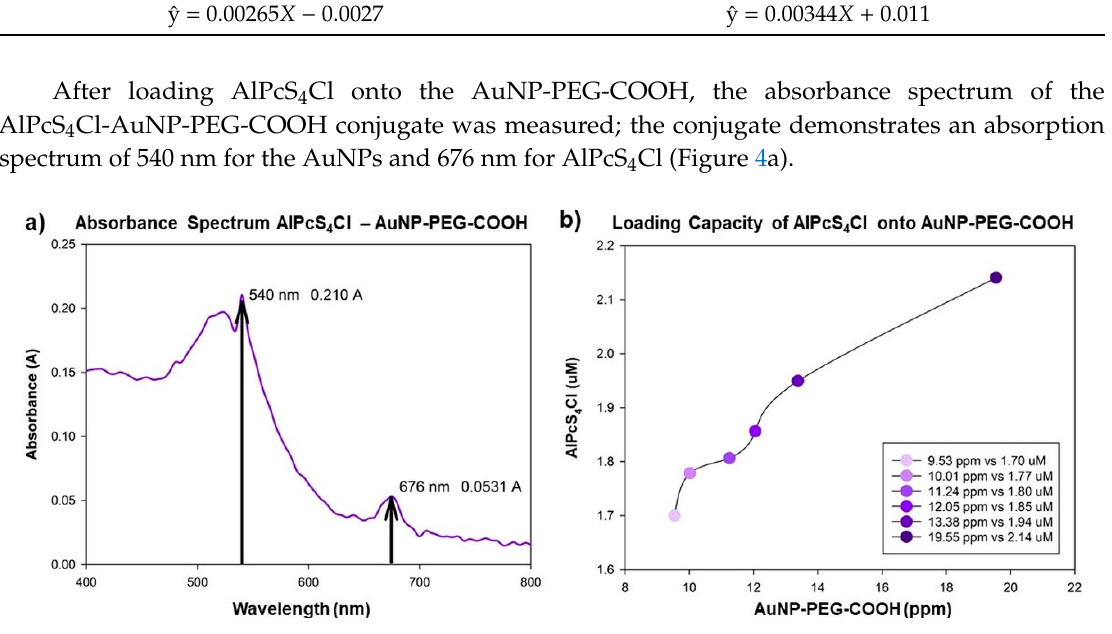
Figure 4. ( a ) Absorbance spectra of conjugated AuNP-AlPcS 4 Cl, with the particle’s respective absorbance peaks at 540 and 676 nm. ( b ) Distribution curve of the concentration of AlPcS 4 Cl ( µ M) relative to the concentration of AuNP (ppm).